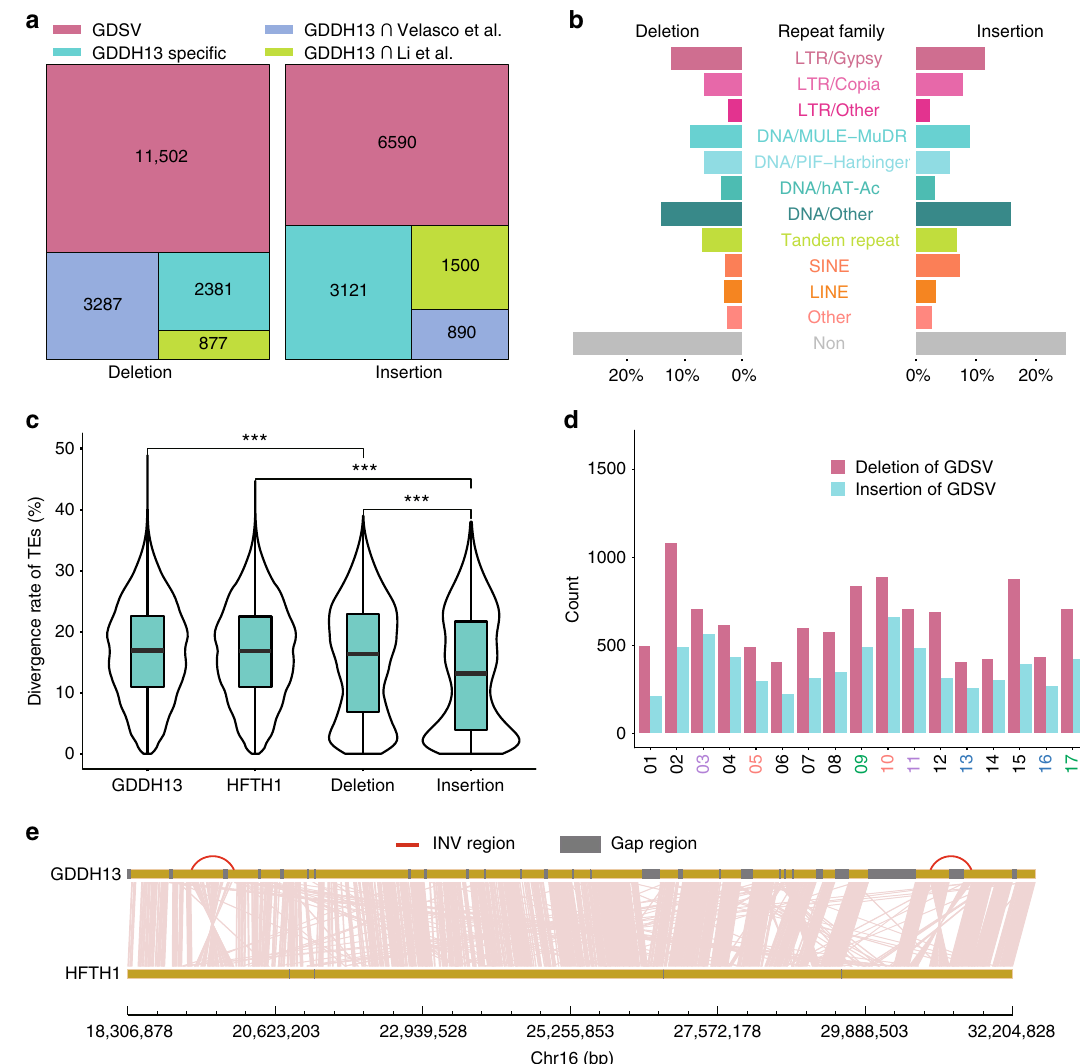
Fig. 2 Characterisation of structural variants. a The overlap of structural variations ( > 100 bp) between GDDH13 and other published assemblies of Golden Delicious. b Classi fi cation of repeat elements associated with structural variations. A repeat element was de fi ned as being associated with a structural variation if it overlaps with the structural variation. LTR, long terminal repeat; DNA, DNA transposon; SINE, short interspersed element; LINE, long interspersed element; Other, other types of repeat; Non, no repeats were detected. c Divergence rate of transposons of different sources. Deletion and insertion represent transposons associated with deletions and insertions, respectively. RepeatMasker was used to calculate the divergence rate from the consensus sequence of Repbase for each transposon. The middle hinge of all boxes is the median, the lower and upper hinges correspond to the 25th and 75th percentiles, and the whiskers represent the 1.5 inter-quartile range (IQR) extending from the hinges. Wilcoxon rank sum test, *** p < 0.001 and n = 435,202, 456,919, 6525, 4010 for GDDH13, HFTH1, Deletion, Insertion, respectively. d Count of structural variations detected in each chromosome. Duplicated chromosomes are shown in the x -axis with the same colour. e Synteny view of two large inversions with a length longer than 600 bp in chromosome 16 (19,782,372 – 20,450,041 and 31,388,523 – 32,032,862). Source data are provided in Source Data fi le